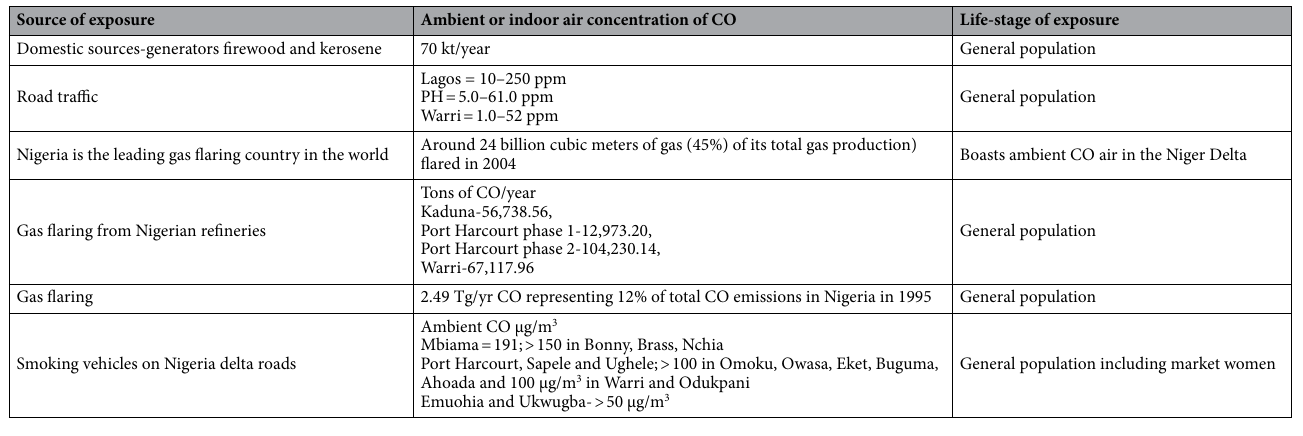
Table 1. Sources of CO pollution in Nigeria 40